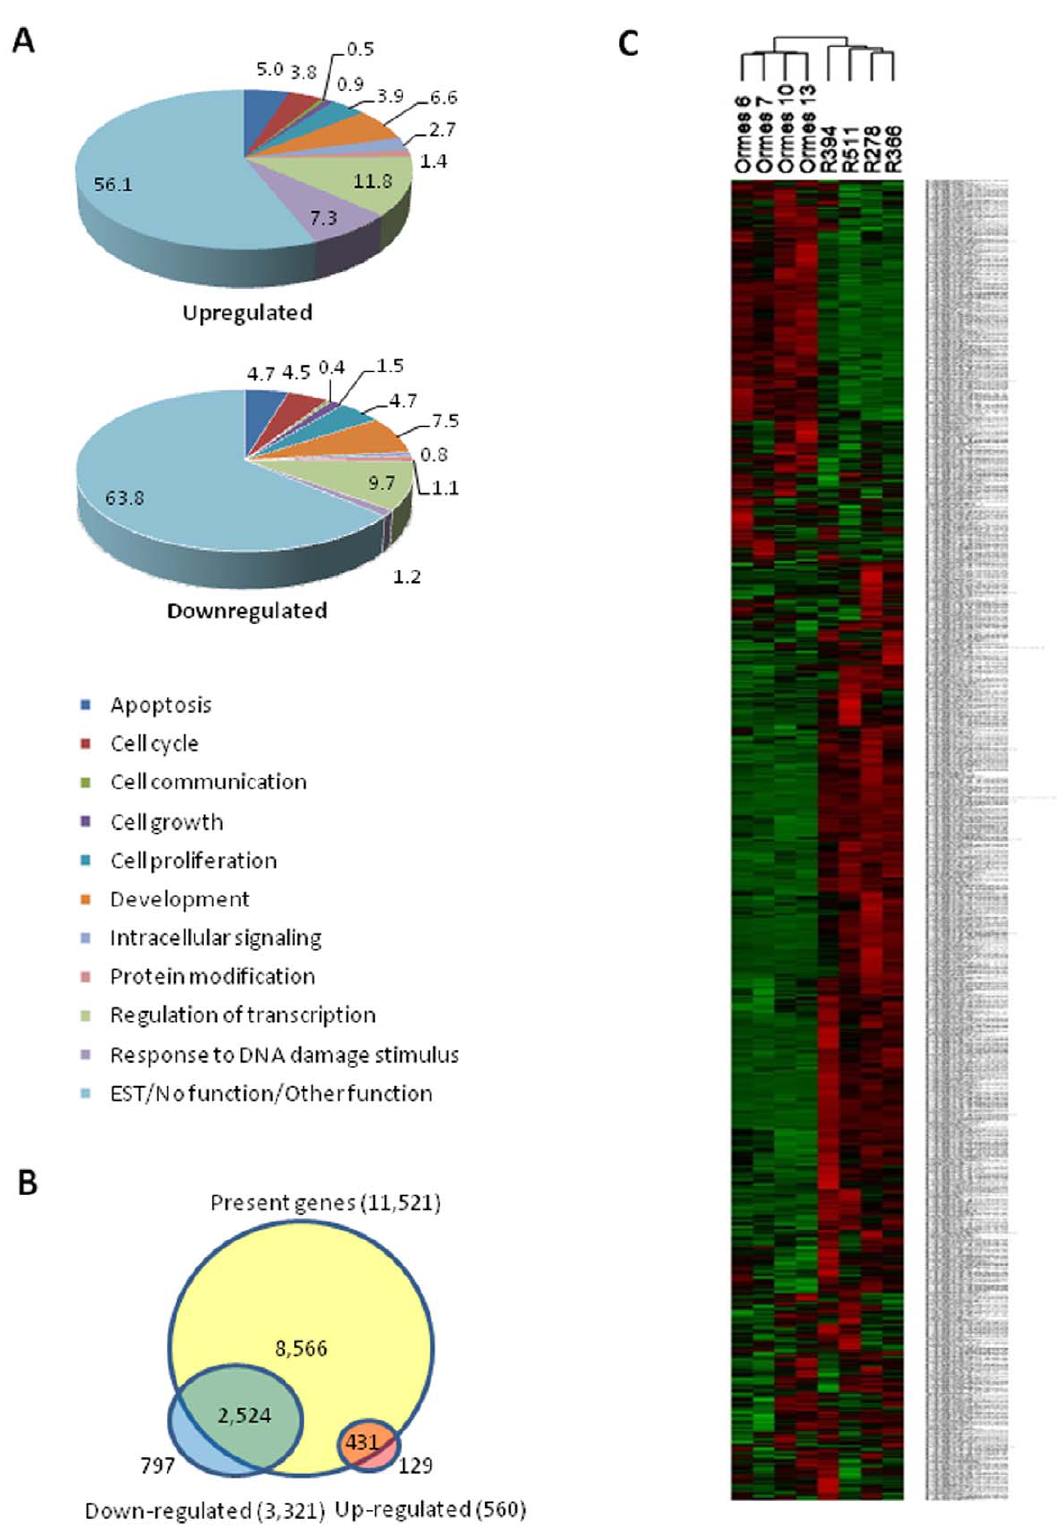
Figure 1. Functional classification and hierarchical clustering of 3881 significantly different transcripts in rhesus ESC. A: Pie charts representing up- and down-regulated biological functions of 3881 differentially expression genes in ESC. Numbers represent percentages of 560 up- and 3321 down-regulated genes in ESC generated from in vitro cultured embryos, compared with ESC generated from in vivo derived embryos. B: Combination Venn diagram of shared and specific genes expressed in ESC originating from in vitro or in vivo derived embryos. The region of overlap between all areas represents the number of genes expressed in ESC from either origin. Regions not overlapping reflect genes expressed specifically in in vitro or in vivo ESC. There are 11521 genes categorized as present (dChip). Of the 3881 genes identified as significant genes from ChipInspector,